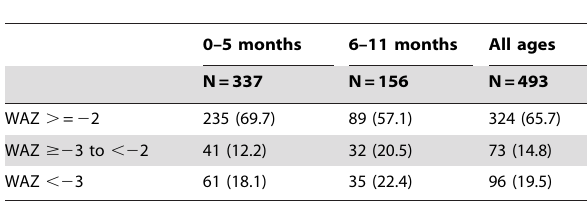
Table 4. Weight-for-Age Status of Selected Infants at Admission into the RUIF Program: Normal, Global Underweight and Severe